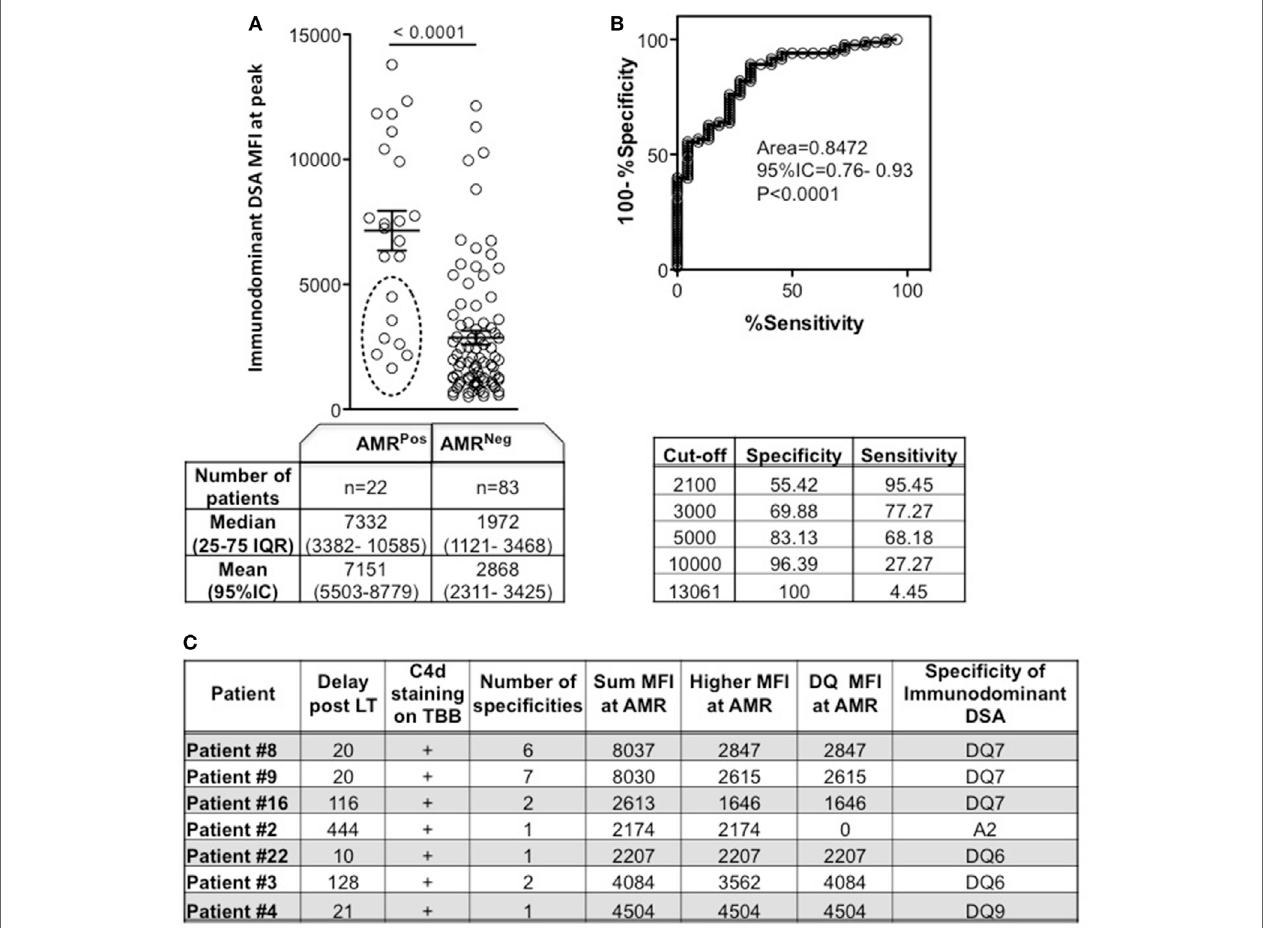
FigUre 2 | Mean fluorescence intensity (MFI) of immunodominant donor-specific antibody (DSA) at peak according to antibody-mediated rejection (AMR) status. Peak was defined as the time point of DSA with the highest sum MFI for AMR Neg (DSA Pos AMR Neg ) patients, or as the time of AMR diagnosis for AMR Pos patients. (a) Each patient’s immunodominant DSA is a circle. Circles inside broken line ellipse ( n = 7) represent patients with AMR despite an immunodominant DSA MFI < 5,000, whose characteristics are detailed in panel (c) (Mann–Whitney test). (b) ROC curve for use of immunodominant DSA MFI as a predictor of AMR diagnosis, and the specificity/sensitivity according to different MFI cut-offs. (c) Characteristics of the 7 AMR Pos patients with immunodominant DSA MFI < 5,000. Significance values are denoted above lines over compared groups.